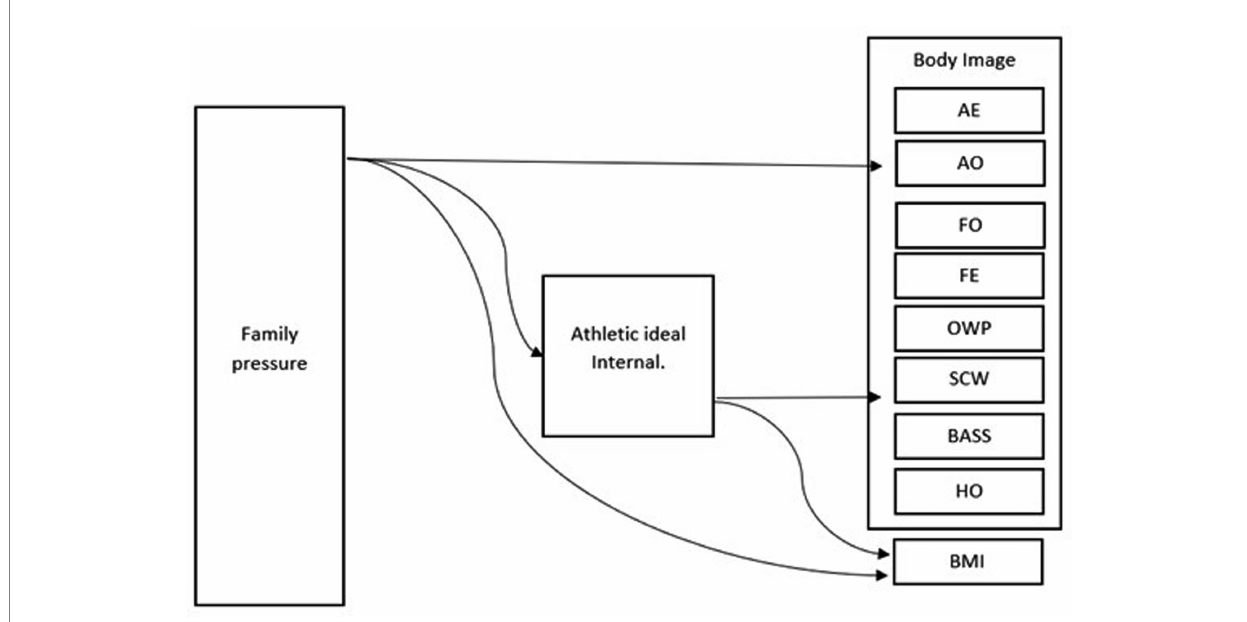
FIGURE 1 Research model: family pressure and body image in young women. The role of internalizing body musculature standards as a mediator between family pressure and the experience of body image. AE, appearance evaluation; AO, appearance orientation; FO, fitness orientation; FE, fitness evaluation; OWP, overweight preoccupation; SCW - self classified weight; BASS, body area satisfaction; HO, health orientation; BMI, body mass index.